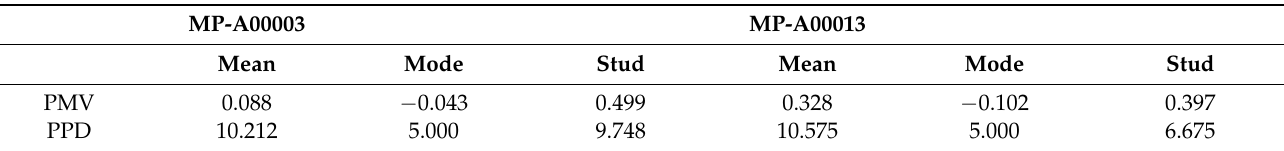
Table 4. Thermal comfort results for the two distinct platforms.